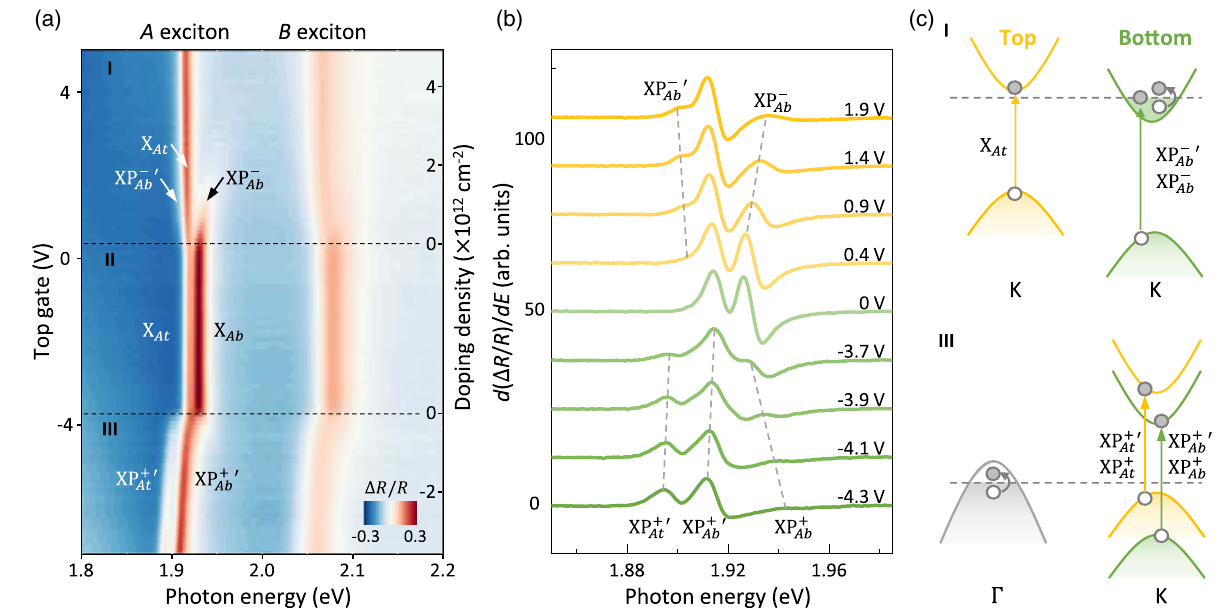
FIG. 2. Doping-dependent reflectance contrast spectrum of intralayer excitons in the 3 R -MoS 2 bilayer. (a) Contour plot of the doping- dependent reflectance contrast spectra of the 3 R -MoS 2 bilayer. The gate voltage is applied proportionally on top and bottom gates with ¼ 0 . 85 V relation V . The right vertical axis denotes the corresponding doping density (positive n for electron doping and negative n for b t hole doping). The black dashed lines divide the spectrum into three regions when the Fermi level is in the (I) conduction band, (II) band gap, and (III) valence band. (b) First energy derivative of the reflectance contrast spectrum in arbitrary units (arb. units) at different top gate voltages. Dashed gray lines denote different exciton polarons in region I and region III. (c) The electronic band structure of the 3 R -MoS 2 bilayer with BA stacking configuration at region I (top) or region III (bottom) in (a). The yellow (green) color denotes the electronic states localized in the top layer (bottom layer). The dashed gray line denotes the Fermi level. In region I, electrons are doped into the conduction band at the K point of the bottom layer. XP − 0 and XP − represent attractive and repulsive exciton polarons, Ab Ab respectively, from the bottom layer when the intralayer excitons X are dressed with electron-hole pairs in the FS. In region III, holes Ab are doped into the Γ point. XP þ0 and XP þ represent attractive and repulsive exciton polarons, respectively. The subscript i is t or b , Ai Ai which denotes the optical transitions at the K points from the top or bottom